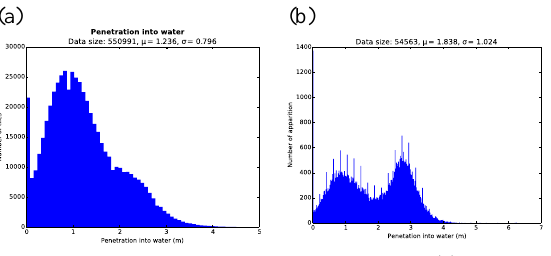
Figure 16. Histograms of water penetration in: (a) all water bodies, and (b) near shore areas only (note, to aid interpretation, histograms are displayed with differing scales).